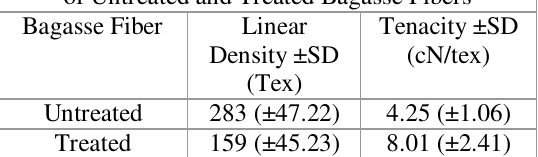
Table 2: The Average Linear Density and Tenacity of Untreated and Treated Bagasse Fibers